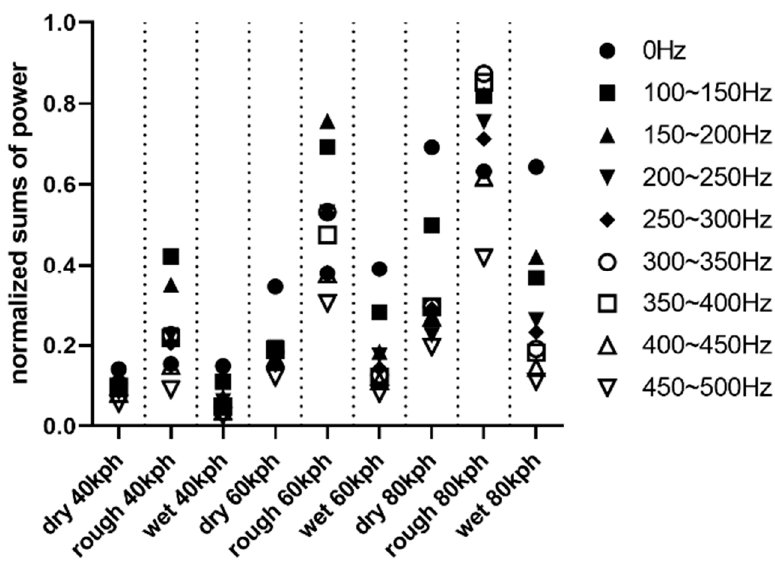
Figure 3. Distribution of normalized sums of power.